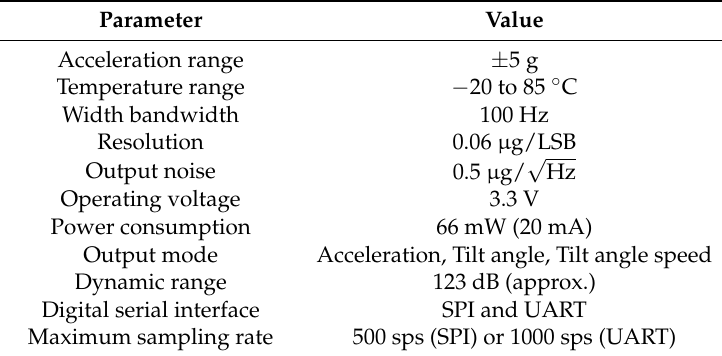
Table 2. M-A351 accelerometer specification [27].